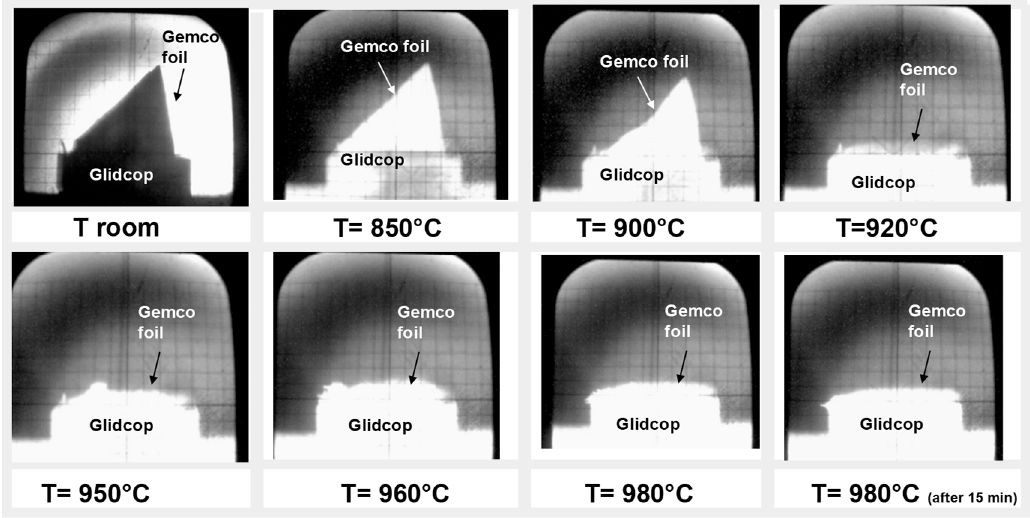
Figure 2. Hot stage microscope images of a Gemco braze foil on Glidcop substrate; the best spreadability was reached at 980 °C (under flowing Ar, heating rate 20 °C·min − 1 ).